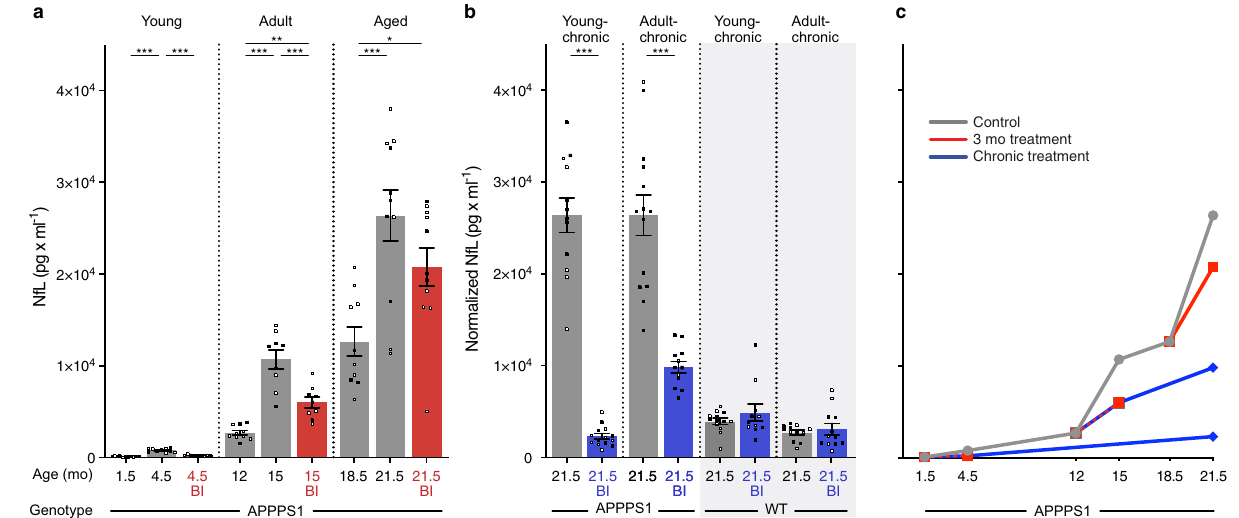
Fig. 4 | NfLinCSF aftershort-term and chronic BACE1 inhibition. a CSFNfL was measuredatbaselineandaftershort-termBItreatmentin ‘ young ’ , ‘ adult ’ ,and ‘ aged